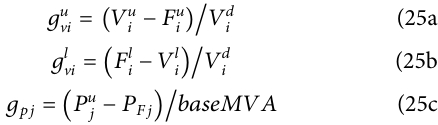
FIGURE 3 | A modi fi ed 39-bus New England